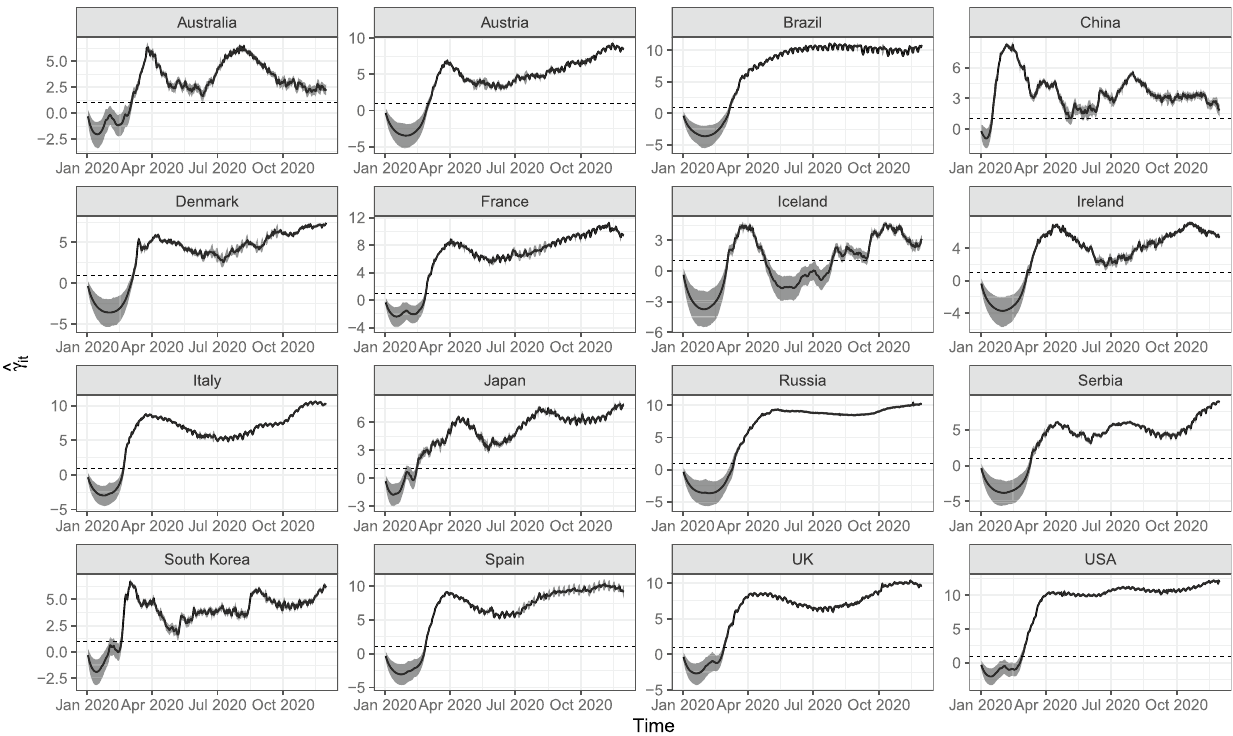
Figure 2. Posterior means of the autoregressive component γ it (solid lines) and associated 95% credible intervals (shaded areas) for each of sixteen selected countries from the pool of 214 countries and territories in the data, from 1-Jan-2020 until